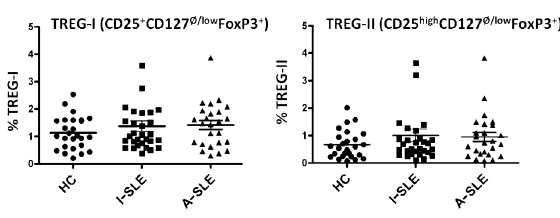
Figure 2. Patients with active SLE (A-SLE), inactive SLE (I-SLE), and healthy controls (HC) display equivalent frequency of TREG cells. The relative frequency of TREG-I (CD25 + CD127 Ø/low FoxP3 + ) andTREG-II(CD25 high CD127 Ø/low FoxP3 + )cellswascalculatedover total CD4 + cells. Horizontal lines indicate means and standard deviation, respectively.